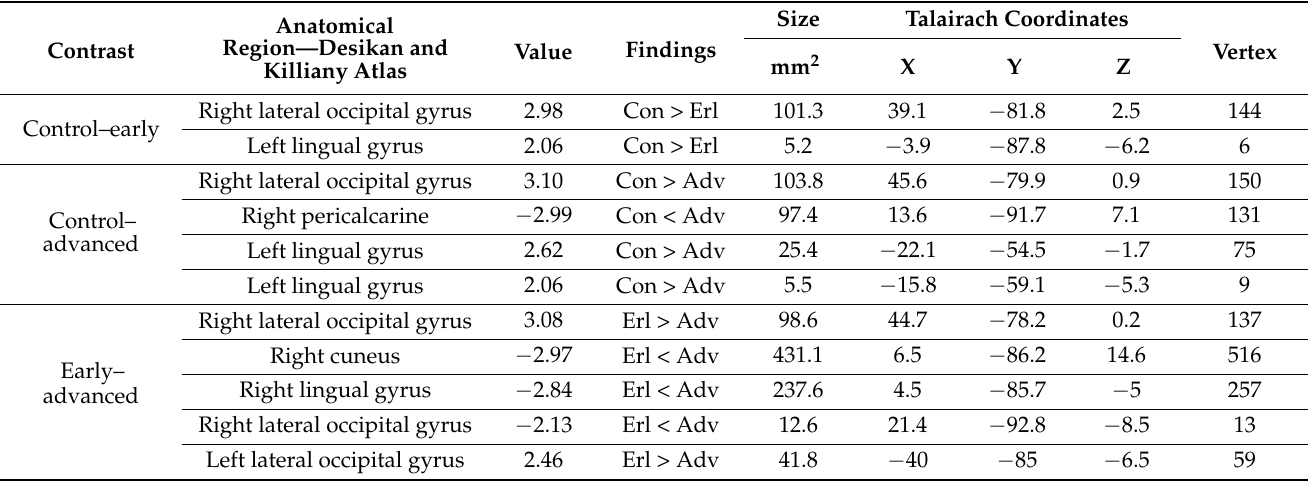
Table 3. Cortical regions from Desikan and Killiany atlas displaying change in thickness between groups—results before clusterwise correction for multiple comparisons.